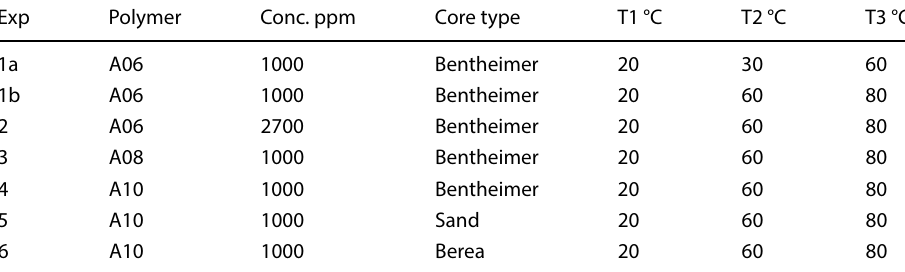
Table 1 Overview of Experiment 1 to 6. The brine was synthetic sea water (SSW)